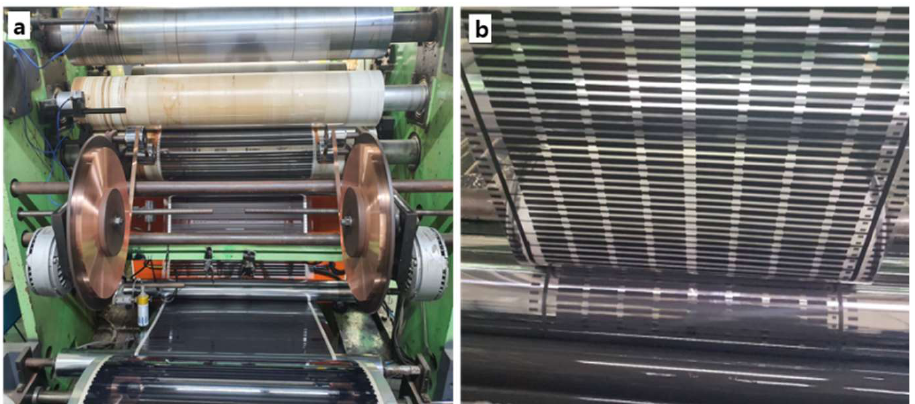
Figure 10. The production of heating film: ( a ) the coating equipment used to perform the gravure method and ( b ) the actual gravure coating process of carbon paste on the base film.